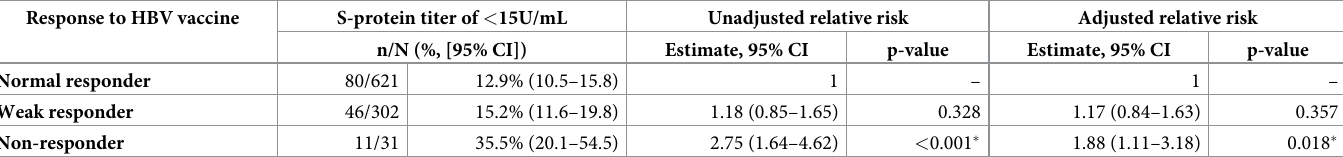
Table 2. Log-binomial regression for the unadjusted and adjusted relative risk non-seroconversion (anti-SARS-CoV-2 spike protein antibody level of < 15 U/mL) after a single dose of BNT162b2 mRNA-1273 COVID-19 vaccine by history of HBV vaccine response among participants with negative SARS-CoV-2 N antibody at baseline (n =